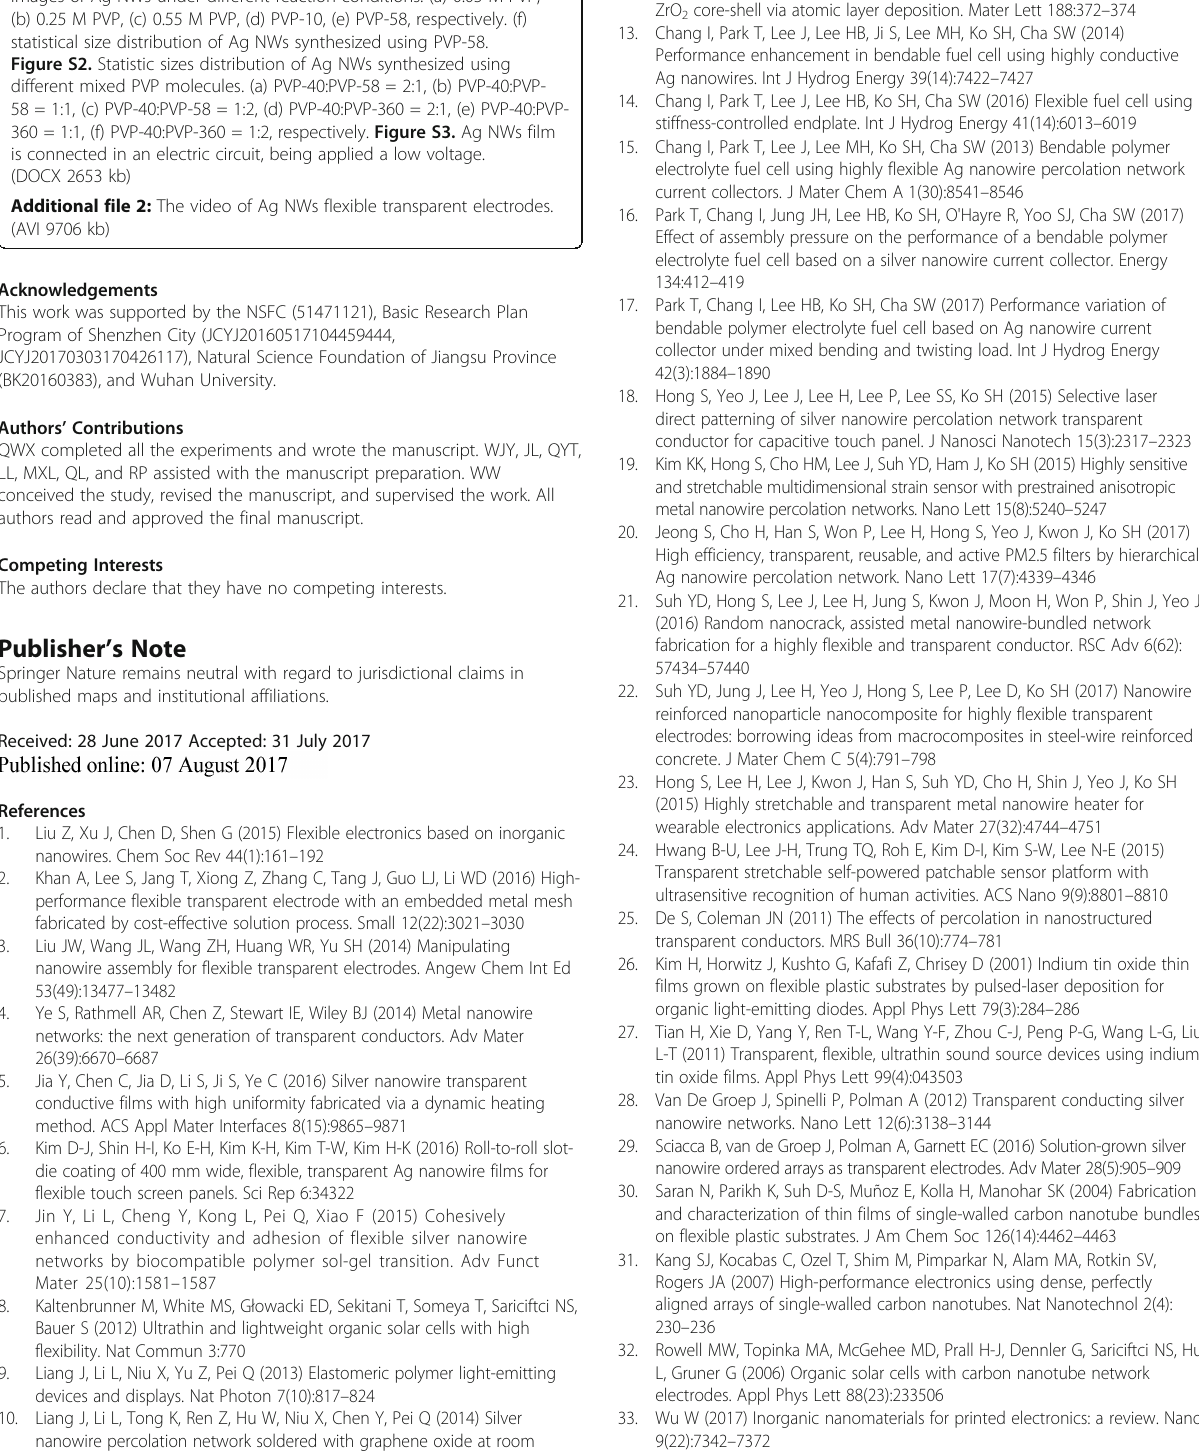
Additional file 1: Table S1. Reaction parameters of Ag NWs with different concentrations of PVP and mixed PVP molecules at different mole ratios. Herein, silver nanoparticles and silver aggregated nanorods are abbreviated to Ag NPs and Ag ANRs, respectively. Figure S1. SEM images of Ag NWs under different reaction conditions: (a) 0.05 M PVP, (b) 0.25 M PVP, (c) 0.55 M PVP, (d) PVP-10, (e) PVP-58, respectively. (f) statistical size distribution of Ag NWs synthesized using PVP-58. Figure S2. Statistic sizes distribution of Ag NWs synthesized using different mixed PVP molecules. (a) PVP-40:PVP-58 = 2:1, (b) PVP-40:PVP- 58 = 1:1, (c) PVP-40:PVP-58 = 1:2, (d) PVP-40:PVP-360 = 2:1, (e)